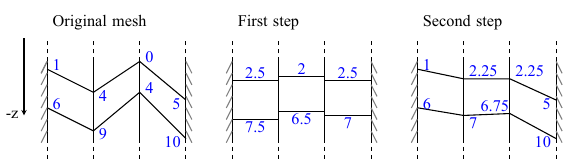
Figure 5. Illustration of the horizontal smoothing algorithm on a 2-D x - z mesh. First, for each element, the upper and lower nodal values of the vertical coordinate z are set to their mean value; then, z is projected onto a continuous field. The numbers refer to the depth of the mesh